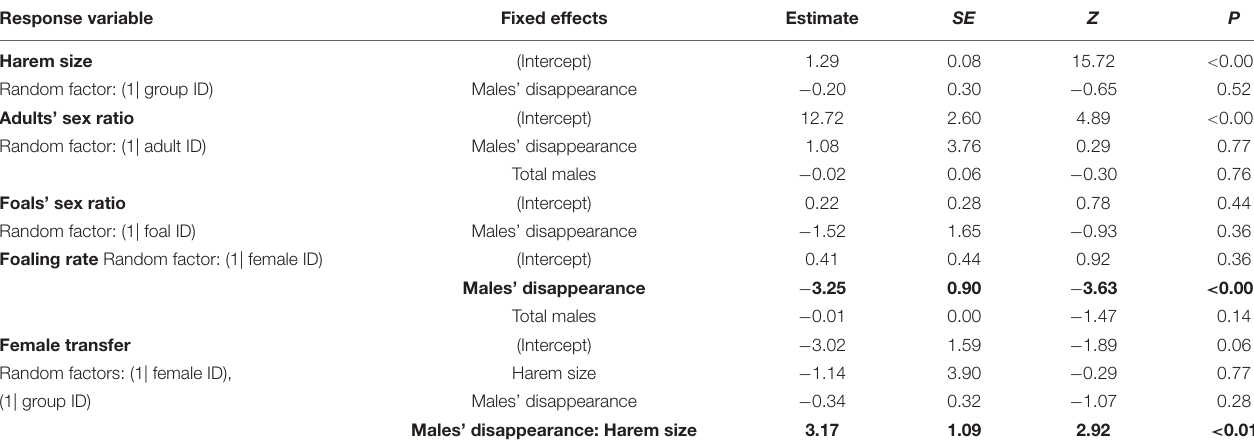
TABLE 4 | Summary statistics for five best fit GLMM that investigated the effect of males’ disappearance and other demographic factors on harem size, adults’ sex-ratio, foals’ sex ratio, foaling rate and female transfers. Response